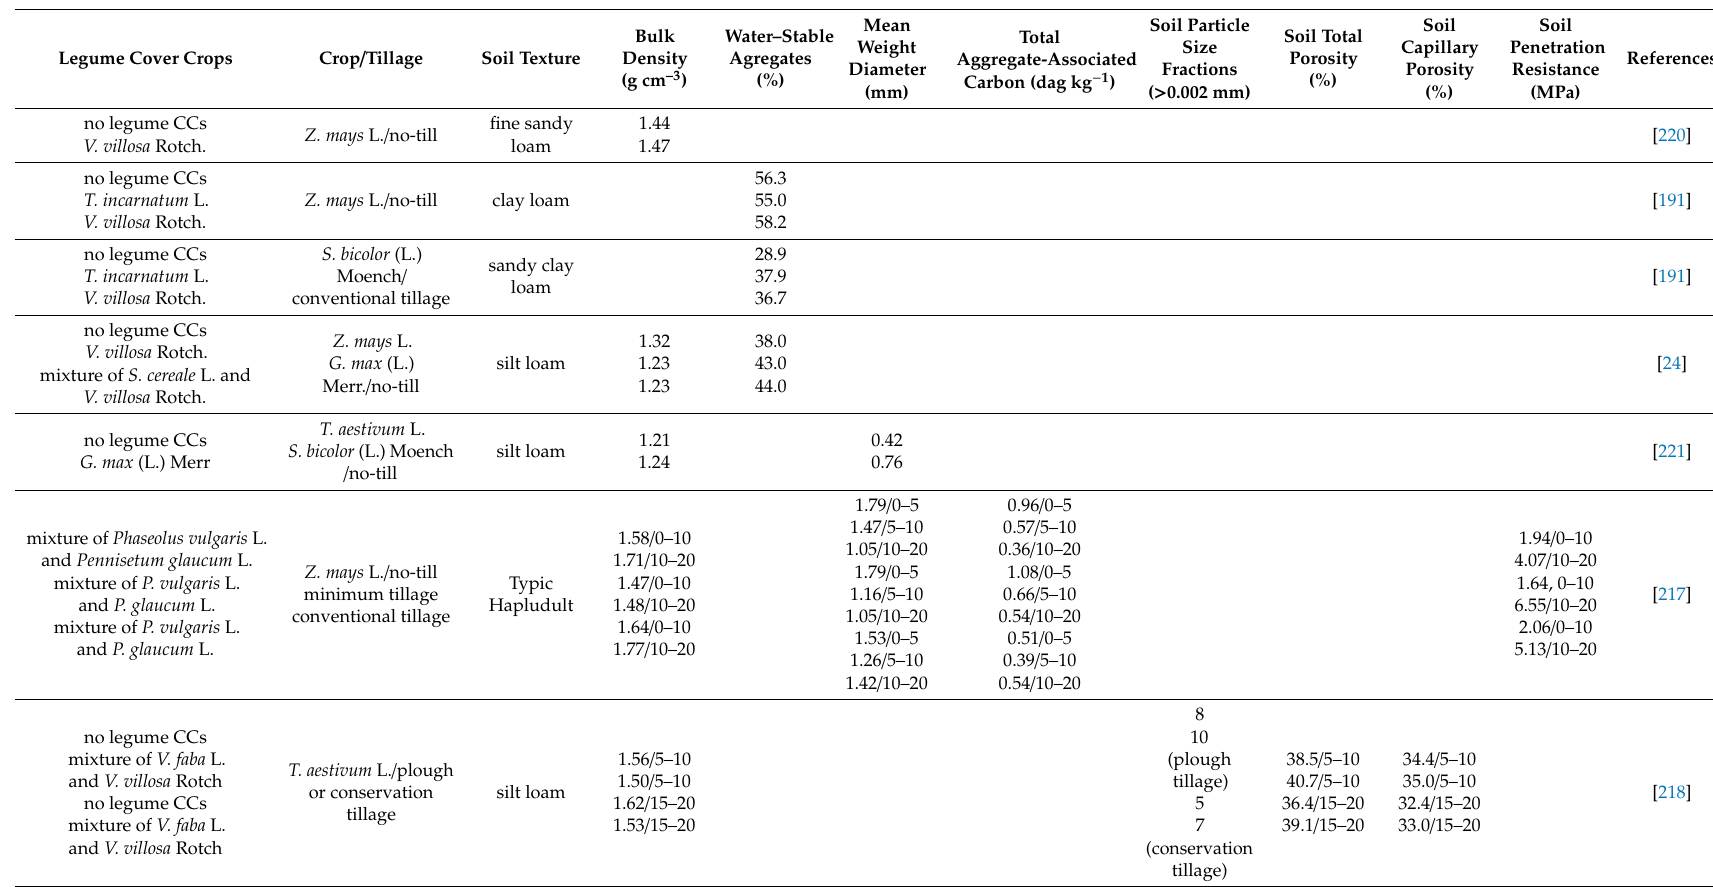
Table 3. E ff ect of legume CCs on the physical properties of